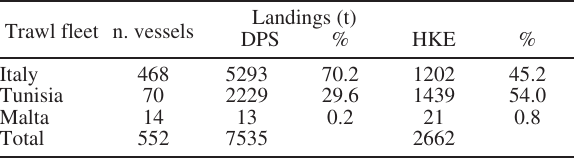
Table 1. – Total landings of deep-water rose shrimp (DPS) and hake (HKE) in the Strait of Sicily by fleet and stock in 2016. Trawl fleet n. vessels